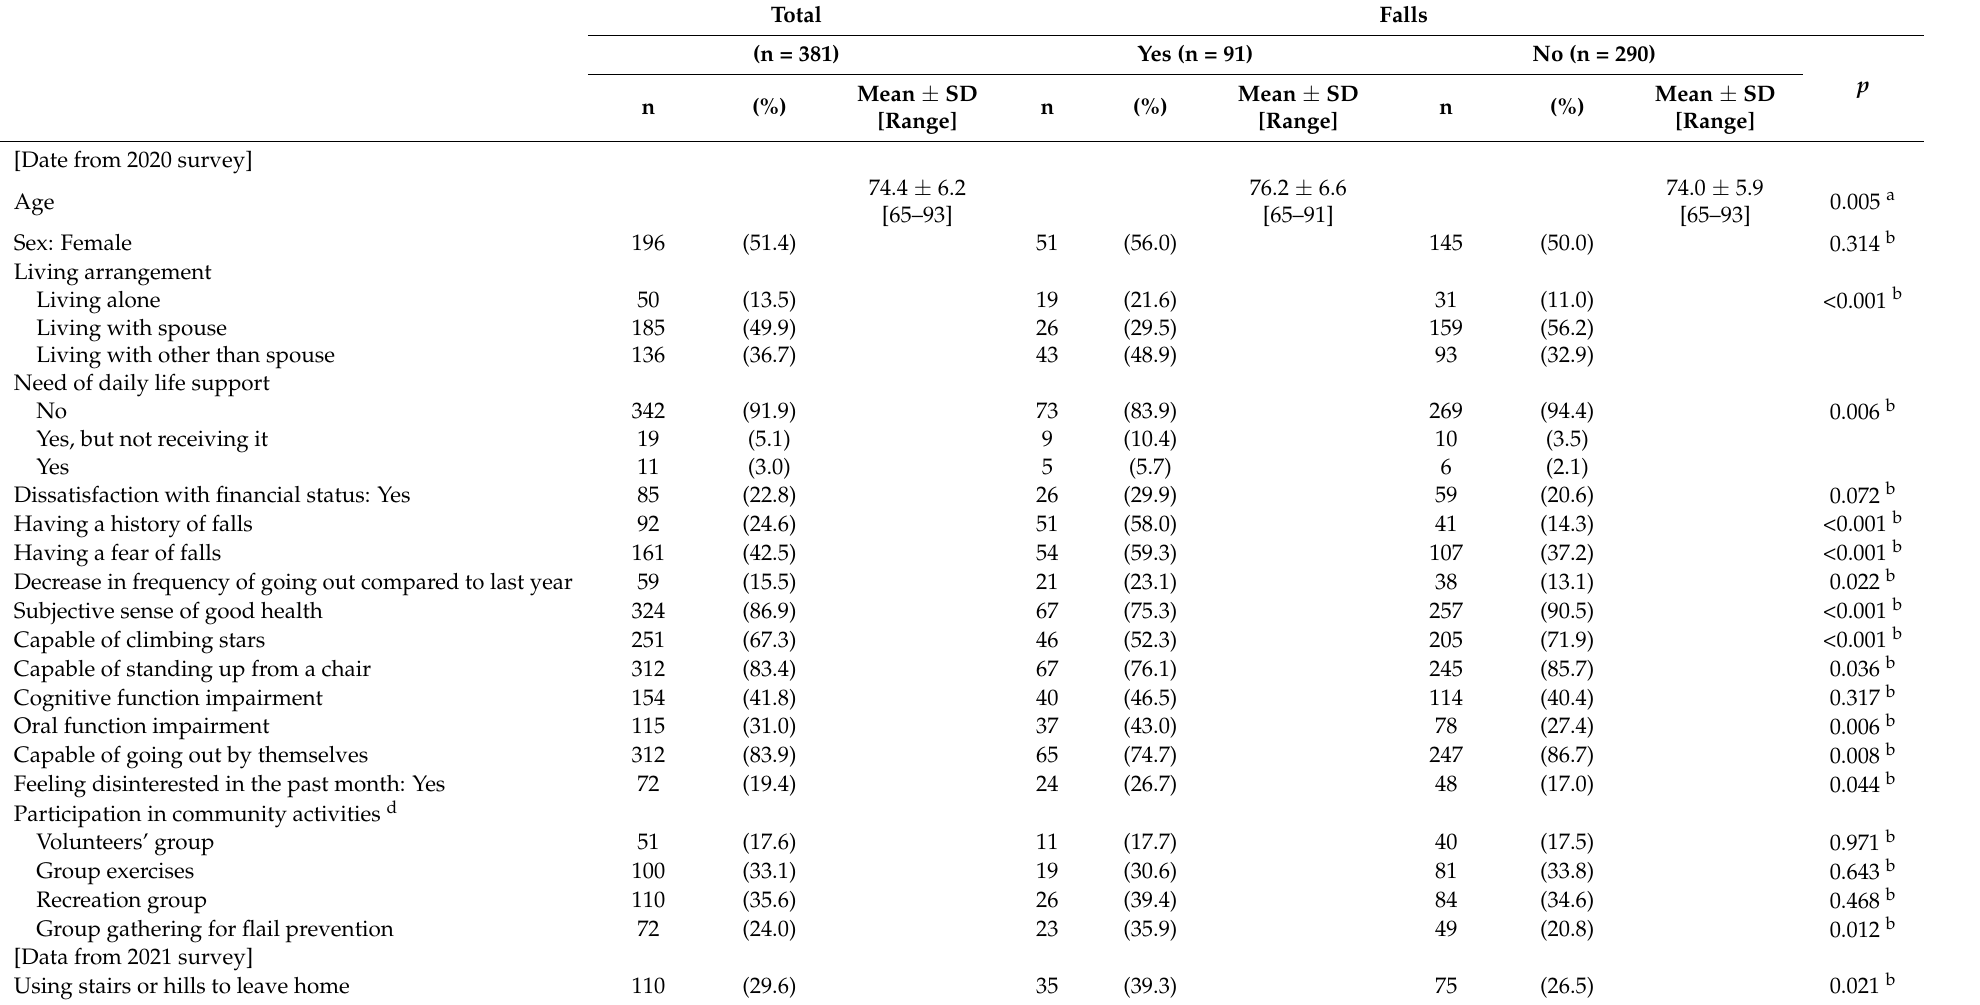
Table 1. Participants’ characteristics and their association with incidence of falls: Univariate analysis (n =